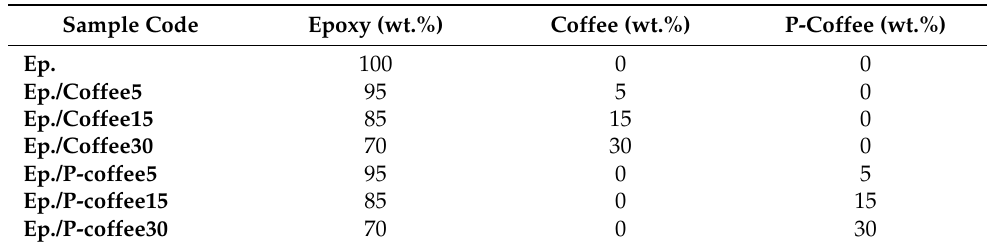
Table 1. Formulations and sample codes of epoxy/coffee biowaste composites (Ep.: epoxy, Coffee: untreated coffee waste, P-coffee: treated coffee waste with dimethyl phosphite). Sample Code Epoxy (wt.%) Coffee (wt.%) P-Coffee